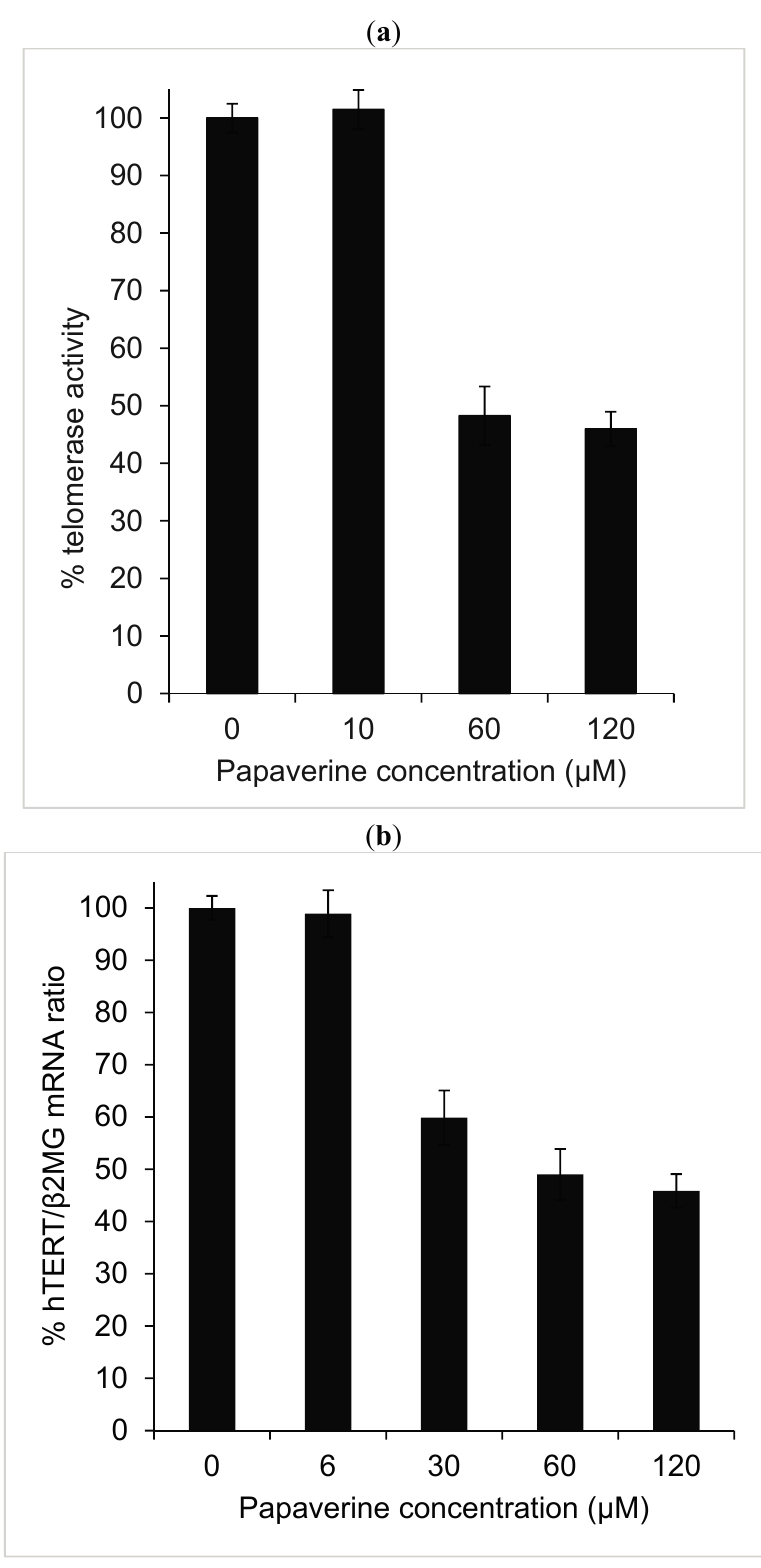
Figure 4. ( a ) Telomerase activity based on qTRAP assay and ( b ) hTERT mRNA level after 48 h treatment with papaverine. Beta-microglobulin mRNA was used to standardize the gene expression experiments. The measurements represent means ±SEM, p ≤